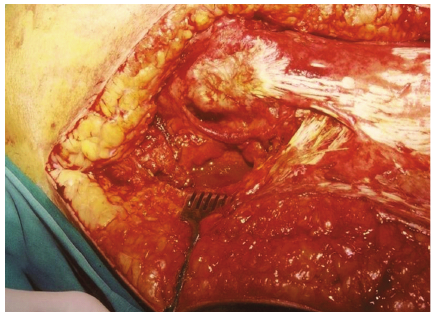
Figure 1: Plain lateral radiograph shows the right femur. Subcuta- neous emphysema is observed as gas in the fascial planes between muscles and subcutaneous tissues.